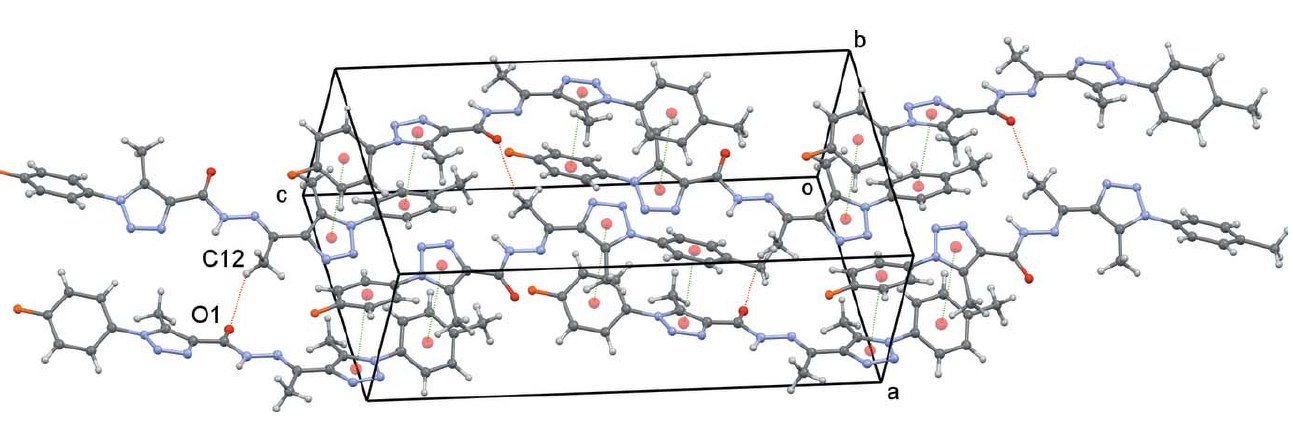
Figure 2 A segment of the crystal structure showing intermolecular (cid:2) – (cid:2) contacts as green dotted lines and C—H (cid:3)(cid:3)(cid:3) O contacts in